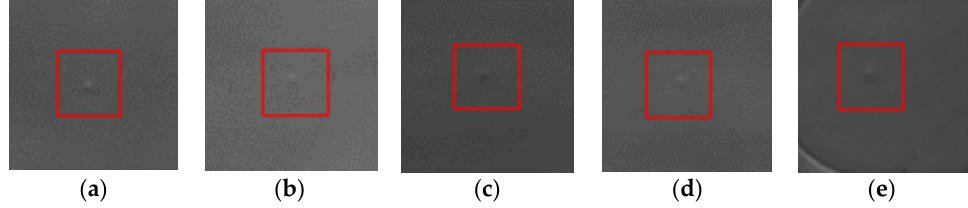
Figure 10. Examples of describing a difficulty of detecting weak-level pits; ( a – e ) undetected pits.